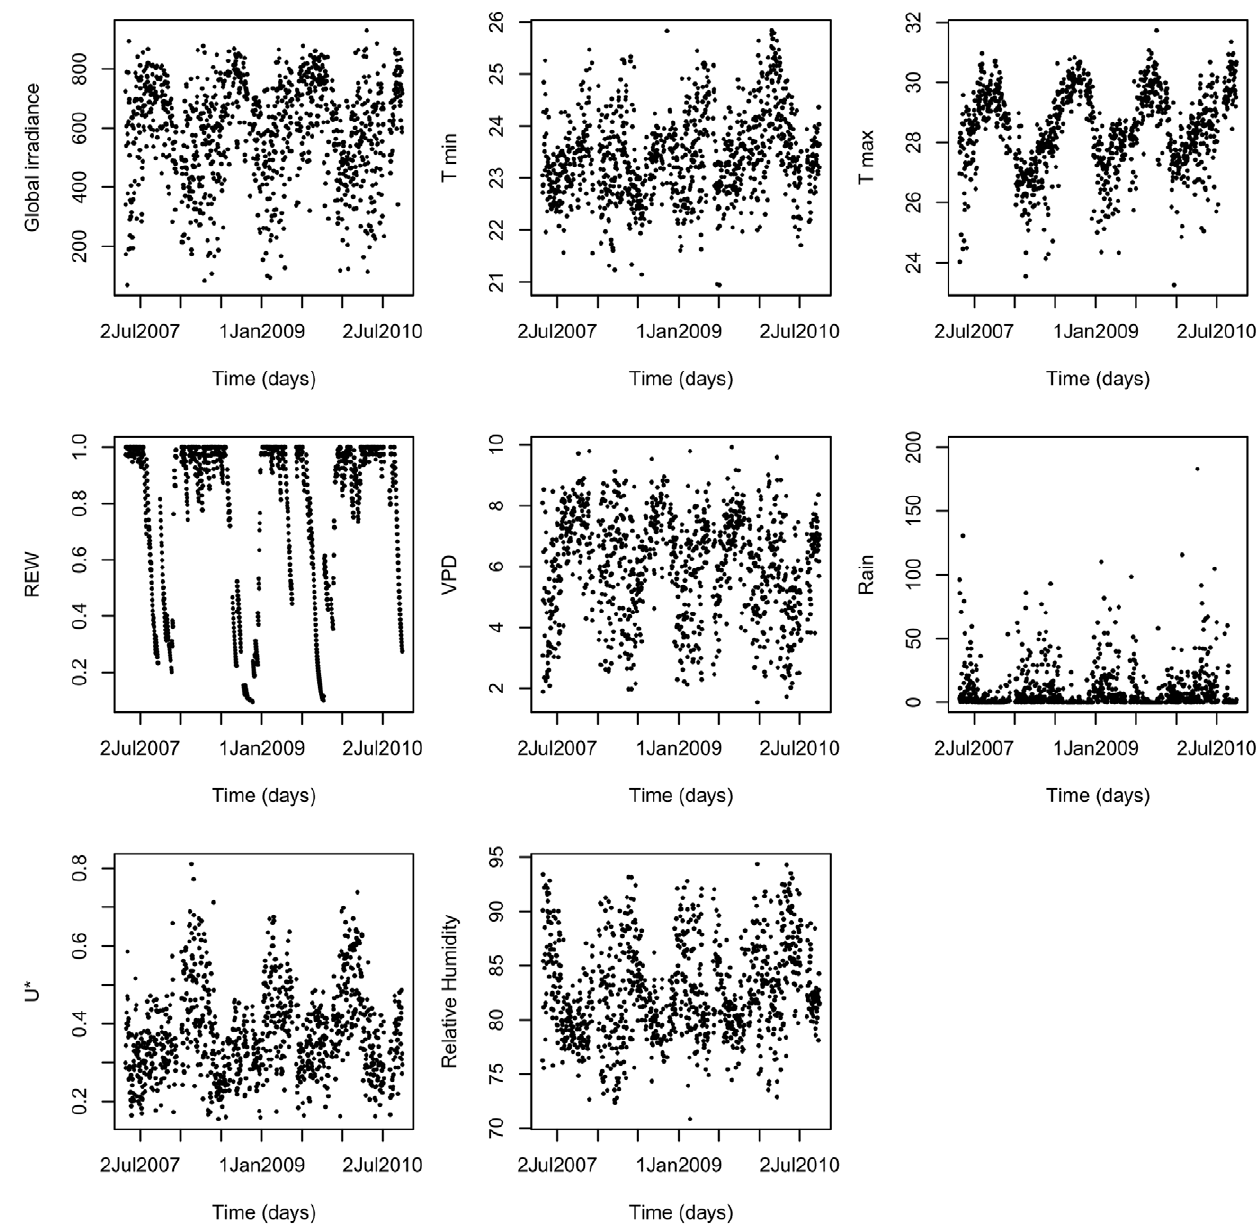
Figure 1. Variation of the climate variables during a 4-year study period in French Guiana. Note that the climate is affected by the north/ south movements of the Inter-Tropical Convergence Zone and the site receives nearly two-thirds of its annual 3041 mm of precipitation between mid-March and mid-June, and less than 50 mm per month during the 3-months dry season. doi:10.1371/journal.pone.0034074.g001 is the error of the model assumed normal. The model (3) was not suited to classical linear regression because the variance nd j s 2 of the error terms changed over the periods j . We normalized the equation (3) to reach residual error variance equality, which led to